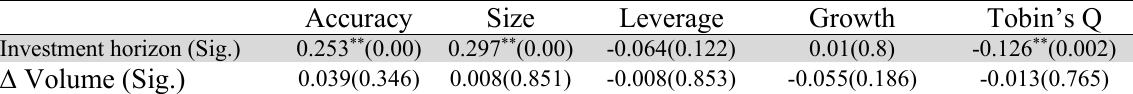
The summary of Pearson correlation ratio Accuracy Size Leverage Growth Tobin’s Q Investment horizon